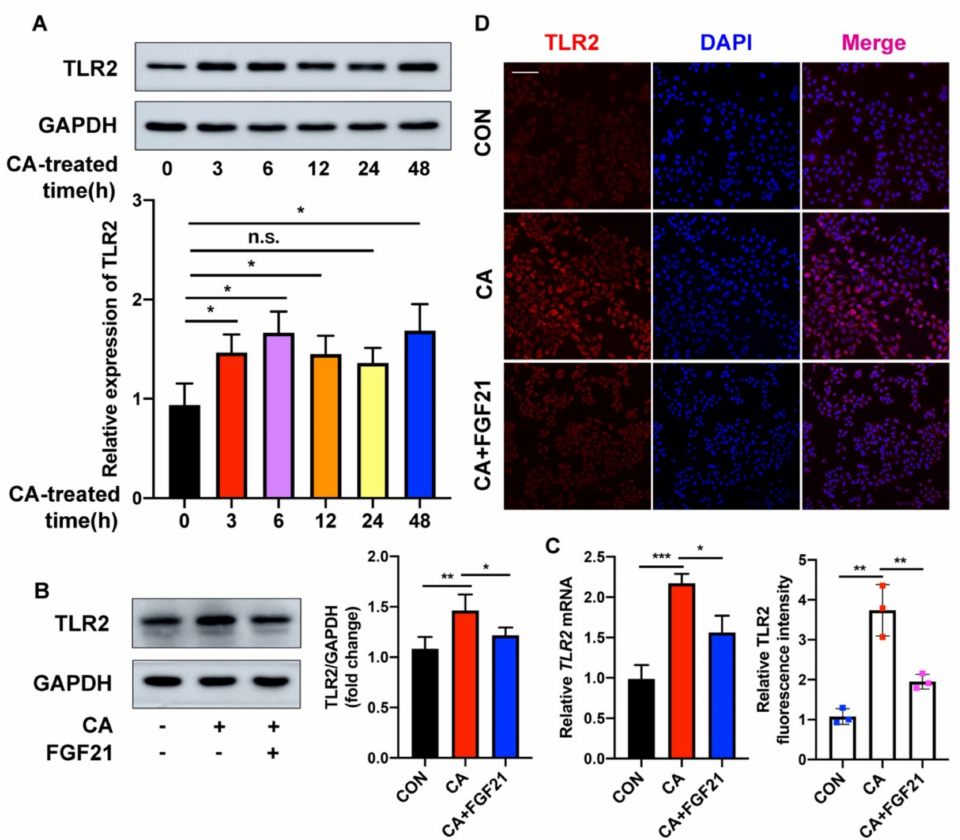
Figure 4. FGF21 ameliorates C. acnes -induced TLR2 activities in HaCaT cells. ( A , B ) The time points included 0, 3, 6, 12, 24, and 48 h after stimulating with C. acnes at the density of 1 × 10 7 CFU/mL. The protein expression level of TLR2 was detected and analyzed in C. acnes -stimulated HaCaT cells with and without FGF21 treatment (20 ng/mL). ( C ) Quantification of TLR2 mRNA level in HaCaT cells subjected to control, C. acnes stimulation, or FGF21 treatment. ( D ) Representative confocal scans are shown for TLR2 (red), and the nuclei are stained with DAPI (blue). Scale bar = 100 µ m. All data are presented as the mean ± the SD; * p < 0.05, ** p < 0.01, and *** p < 0.001; n.s.,